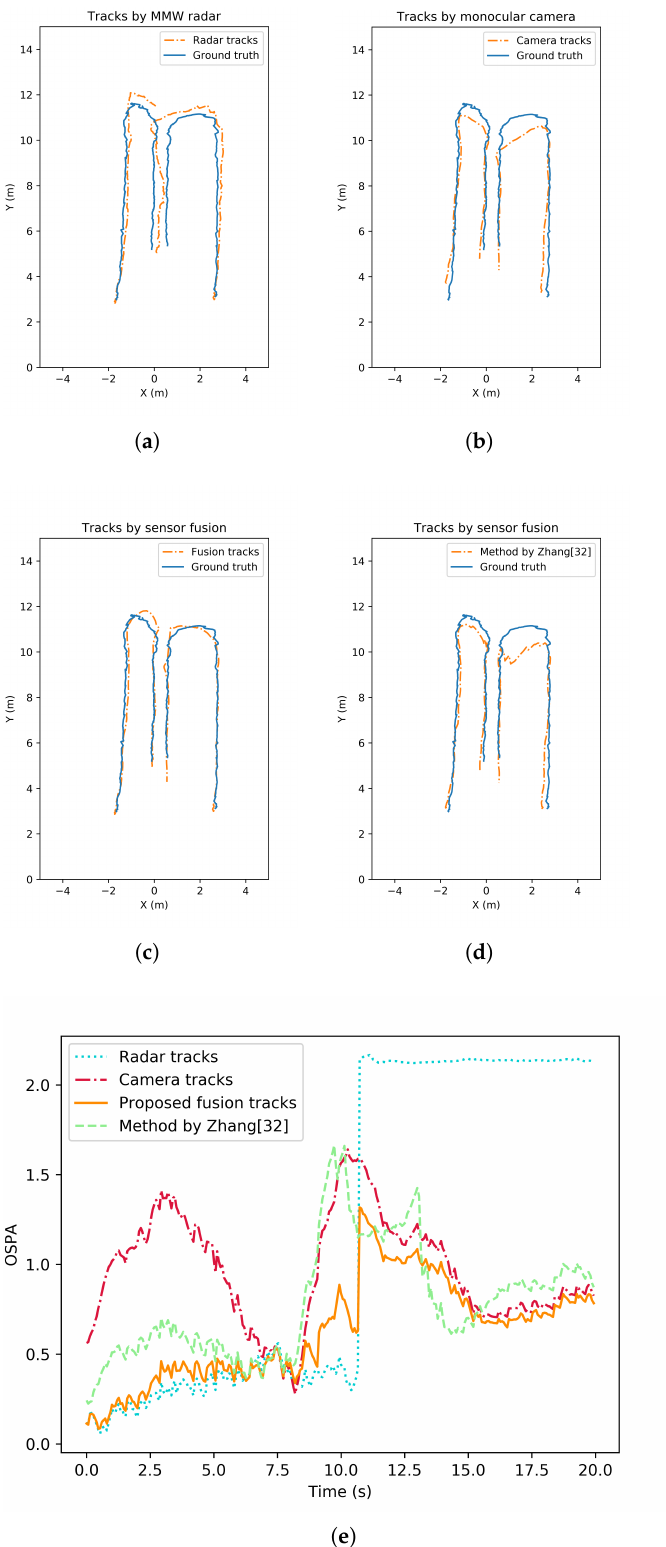
Figure 8. Pedestrian tracking performance comparison under multi targets situation. ( a ) Tracking trajectories by MMW radar. ( b ) Tracking trajectories by monocular camera. ( c ) Tracking trajectories by the proposed fusion strategy. ( d ) Tracking trajectories by the method from [32]. ( e ) Tracking performance comparison in